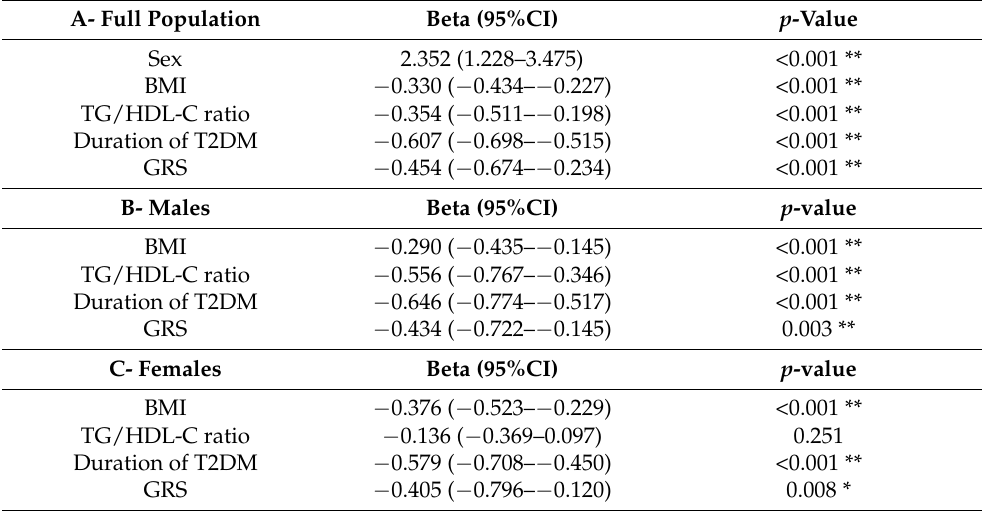
Table 2. Association of genetic risk scores (GRS) with the age of onset for T2DM by full Case population (A) and separate for sex (B in males, C in females). The association was evaluated under adjusted regression models (sex, BMI, TG/HDL-C